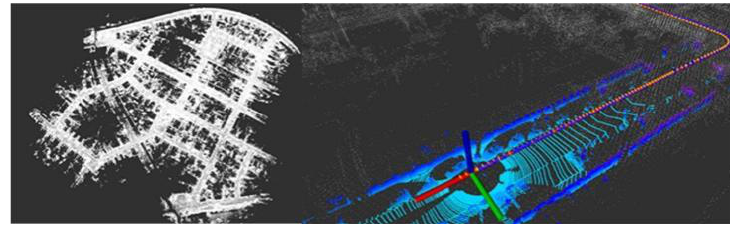
Figure 4. Optimized map and LiDAR localization result based on KITTI dataset.